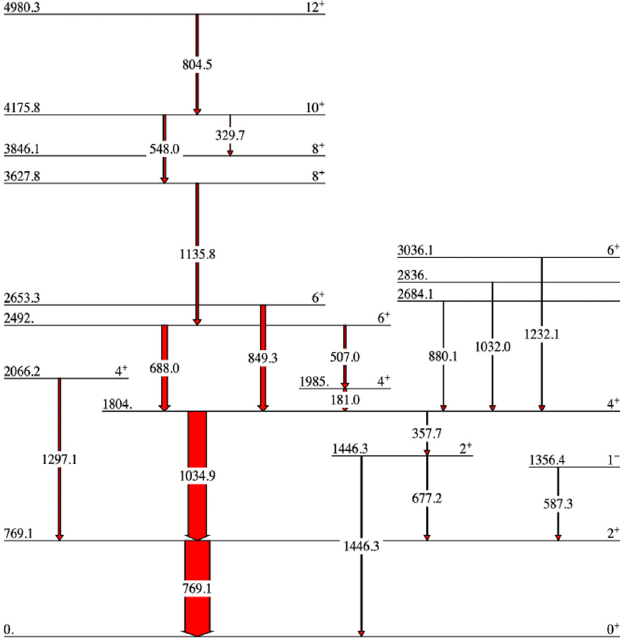
Fig. 7. Low energy part of the level scheme and gamma-cascade of 92 Kr calculated with FIFRELIN (RIPL3-2015). The intensities of 1034 and 1297 keV transitions are